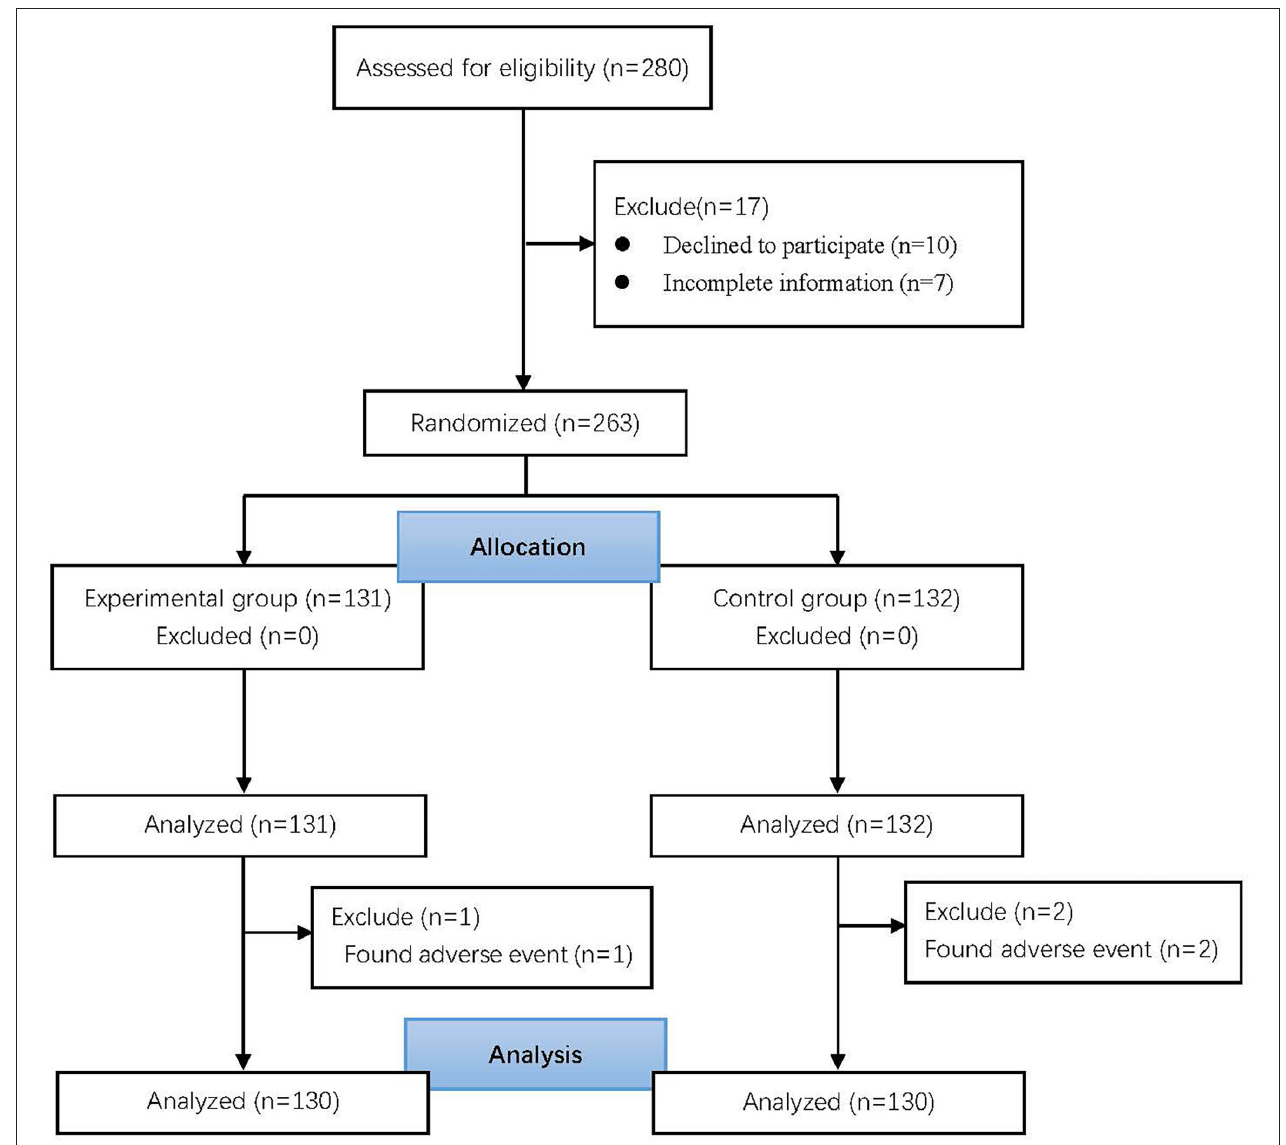
FIGURE 1 | Flowchart of selection